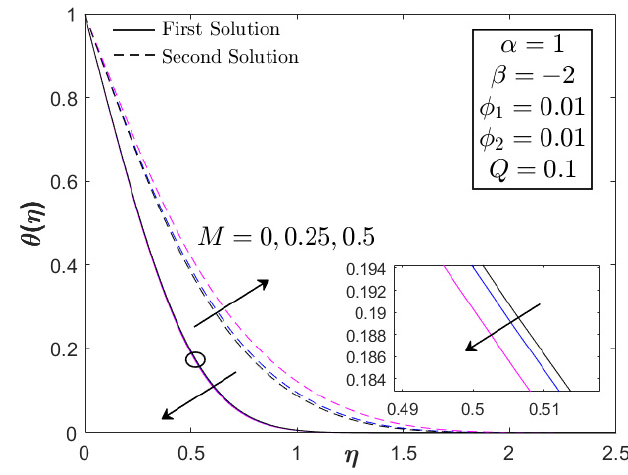
Figure 10. Velocity profile of Fe 3 O 4 –CoFe 2 O 4 /H 2 O with different M .